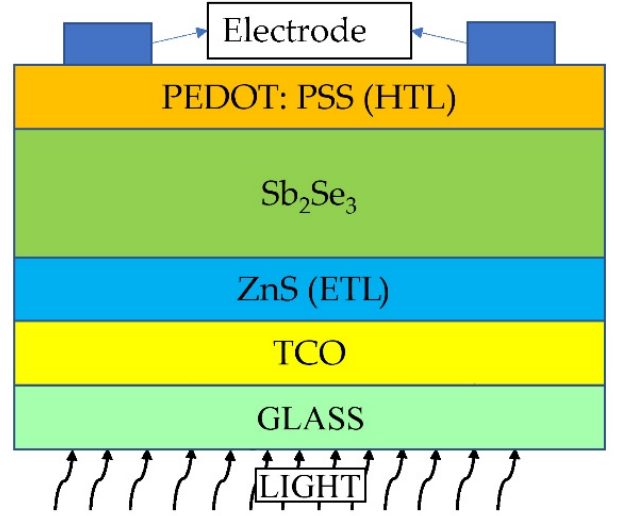
Figure 1. Structure of the Sb 2 Se 3 solar cell device.